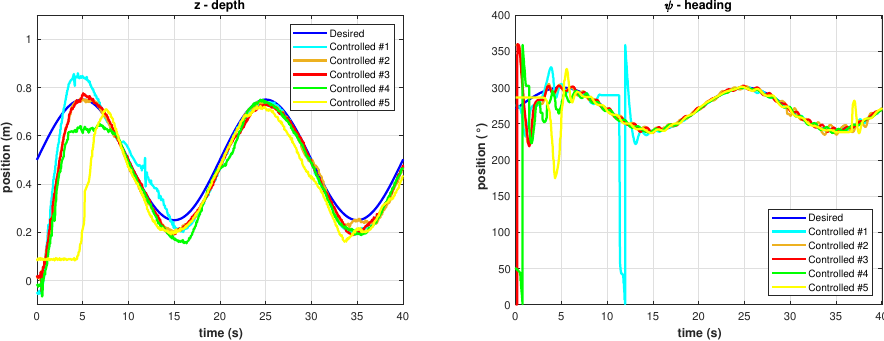
Figure 7. Controlled trajectories with the PID controller. ( Left ) Depth. ( Right ) Heading.